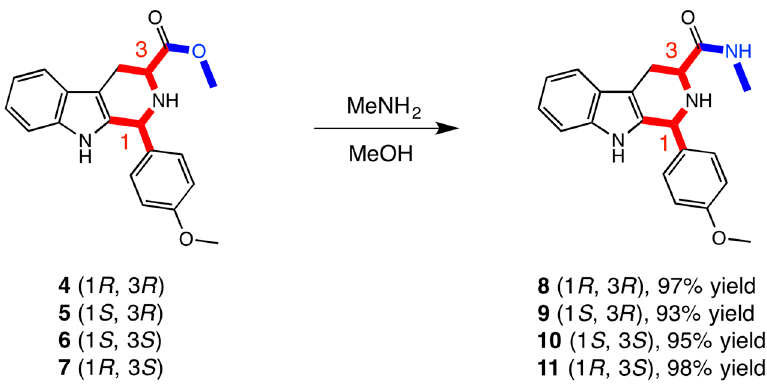
Figure 2. Catalyst-free amidation of tryptoline methyl ester derivatives 4 – 7 with methylamine under mild conditions.